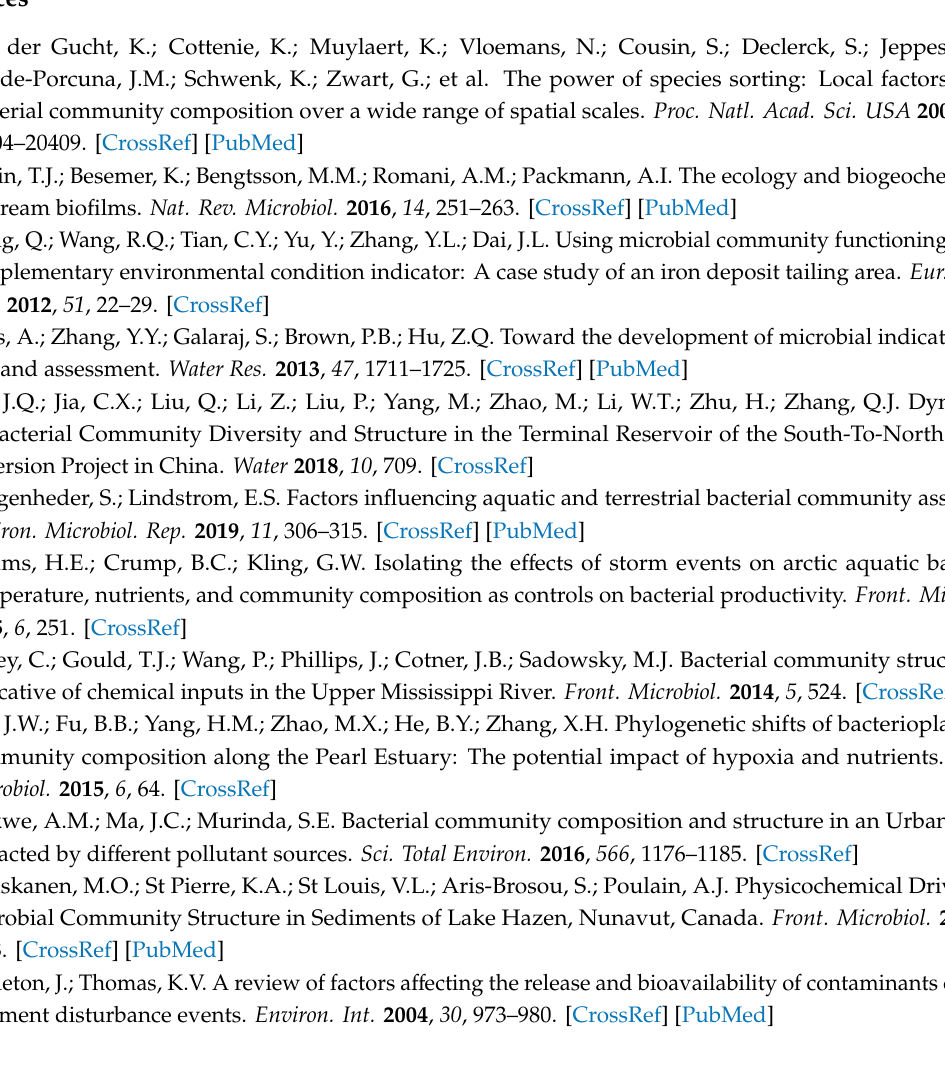
Table S1: Physical and chemical properties of experimental sediment, Table S2: Comparison of OTU numbers and diversity indexes of bacterial community in the water-sediment systems over time, Table S3: The detailing taxon shared among groups of water and sediment samples at week 5, Figure S1: Rarefaction curves of OTUs richness clustered at 97% sequence identity. (a) Water, (b) Sediment. SC: static control, SVC slow velocity condition, FVC: fast velocity condition. The subscript S denotes the sediment and W denotes the water, Figure S2: Relative abundance of γ -Proteobacteria along the timescale (week 0–5). (a) Water, (b) Sediment. SC: static control, SVC slow velocity condition, FVC: fast velocity